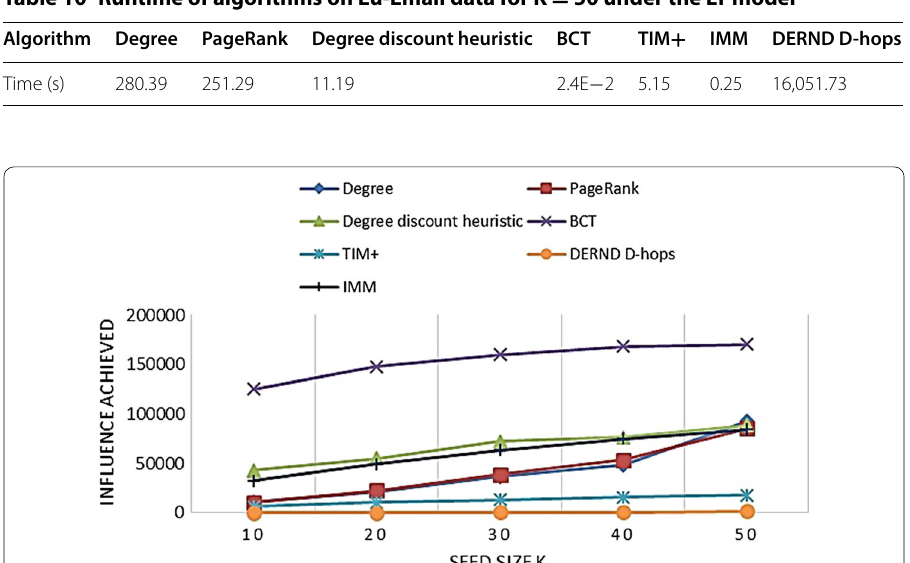
Fig. 8 Influence spread under the LT model of Eu-Email data. Degree PageRank Degree discount heuristic BCT TIM UERND D-hops IMM +